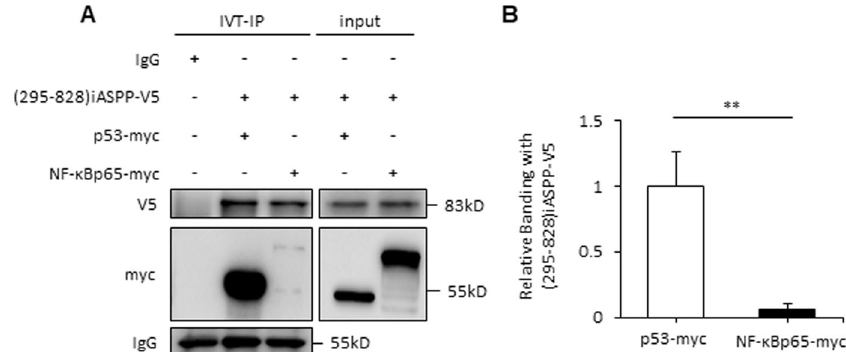
Fig. 7 iASPP(295 – 828) binds with p53 more ef fi ciently than with NF- κ Bp65. The interaction between (295 – 828)iASPP and p53 and NF- κ Bp65 were determined by a co-IP assay using in vitro-translated (295 – 828)iASPP-v5, p53-myc, and NF- κ Bp65 ( A ). The bar graph represents the relative p53 or NF- κ Bp65 proteins that bound with (295 – 828)iASPP ( B ). ** p <